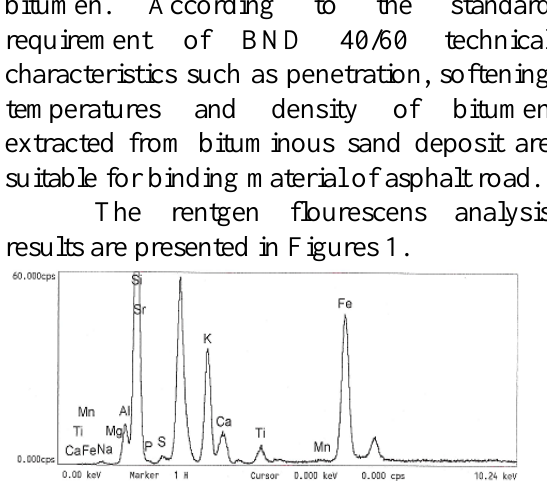
Figure 1 - X-ray spectrum of the mineral part of bituminous sand of the Bayan-Erhet deposits Table 4. Chemical composition of minerals of bituminous sand